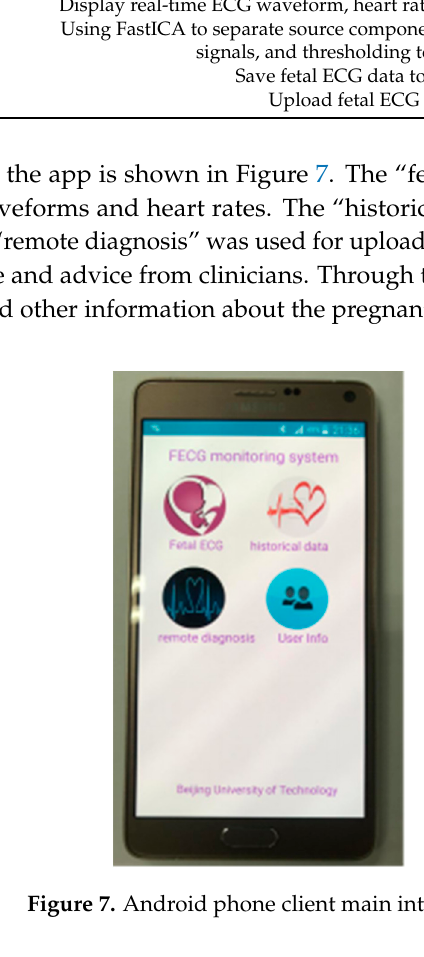
Figure 8. Five-channel abdominal signals from the DaIsy database. Three channels of signals were selected from the five-channel DaIsy database for FastICA separation. Each channel corresponded to a different position on the maternal abdomen for signal collection. For Ch1, Ch3, and Ch4 signals from the pregnant woman (Figure 8), the three source component signals, separated by the FastICA algorithm, are shown in Figure 9. Figure 9a,b,c show the fetal ECG signal, the maternal abdomen mixed signal, and the maternal ECG signal, respectively. The fetal and maternal ECG signals had similar morphology, but the fetal heart beat frequency was higher